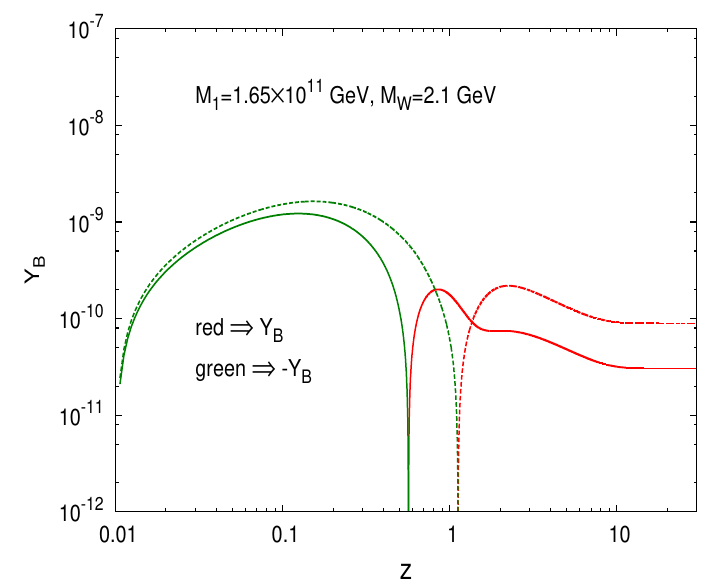
Figure 10 . Variation of Y B with z , where the dashed line represents baryon asymmetry with pure N 2 contribution and the solid line represents Y B excluding it. Lagrangian parameters are (cid:12)xed at best (cid:12)t and M w is chosen to be 2 : 1 GeV. At this value of M w , we can get experimentally allowed asymmetry only if the pure N 2 contribution is taken into